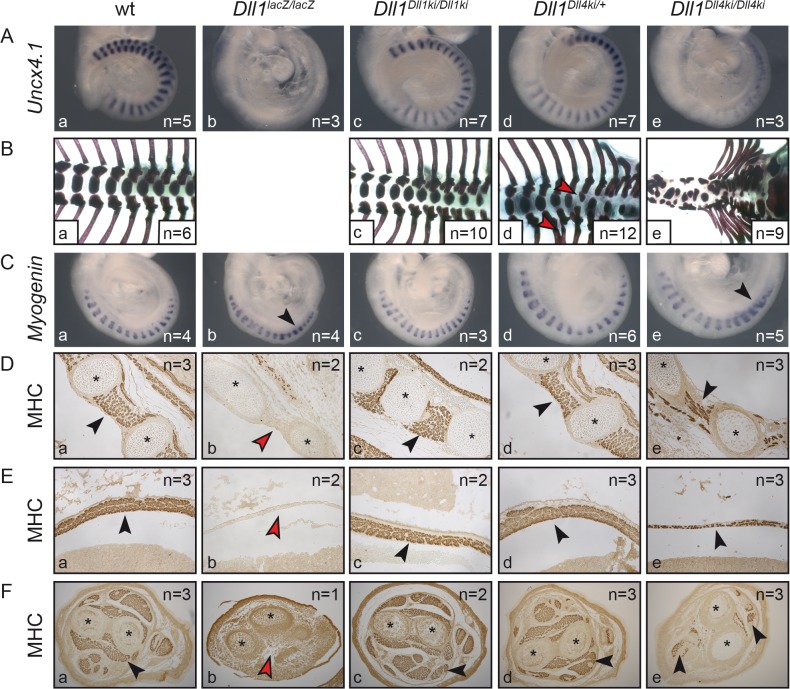
Homozygous Dll1
Dll4ki mice fail to generate proper somites and form reduced skeletal muscle tissue.Examination of Dll1-dependent (A,B) somitogenesis and (C-F) myogenesis in (a) wildtype, (b) Dll1
lacZ/lacZ, (c) Dll1
Dll1ki/Dll1ki, (d) Dll1
Dll4ki/+ and (e) Dll1
Dll4ki/Dll4ki embryos or foetuses. (A)
Uncx4.1 in situ hybridisation of E9.5 embryos. (B) Skeletal preparations of E18.5 foetuses (Dll1
lacZ/lacZ foetuses do not survive until E18.5; red arrowheads indicate fused ribs or hemivertebrae in heterozygous Dll1
Dll4ki skeletons in d). (C)
Myogenin in situ hybridisation to visualise differentiating skeletal muscle cells in myotomes of 17–18 somite stage embryos. (D, E,F) Anti-myosin heavy chain (MHC)-antibody staining of sectioned E15.5 foetuses showing intercostal muscles (D), the diaphragm (E), and muscles in the cross-section of forelimbs (F); black arrowheads indicate examples of muscle tissue, red arrowheads show lack of muscle tissue; asterisks label ribs (D) or bones of the forelimb (F).